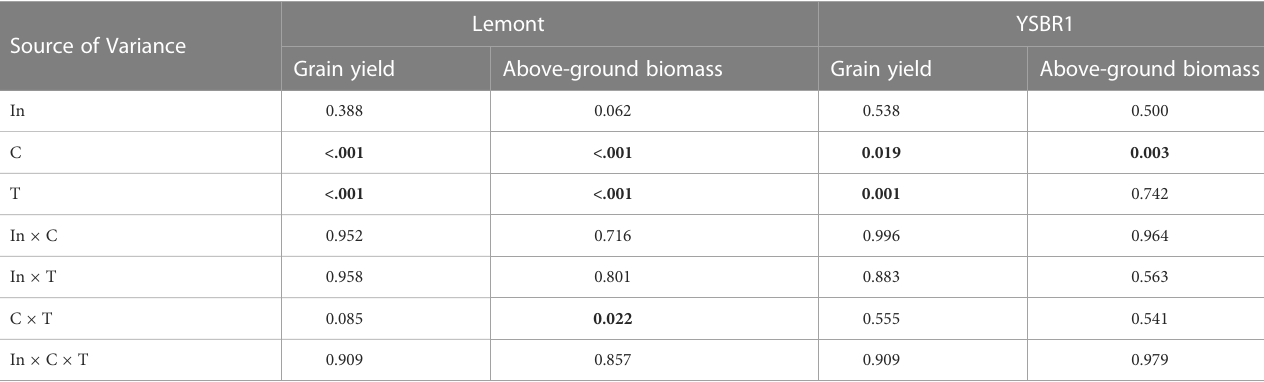
TABLE 5 Summary of analysis of variance (ANOVA) for the in fl uence of inoculation, CO 2 and temperature on above-ground biomass and grain yield of cvs Lemont and YSBR1 in 2021 a . Lemont YSBR1 Source of Variance Grain yield Above-ground biomass Grain yield Above-ground biomass In 0.388 0.062 0.538 0.500 C <.001 <.001 0.019